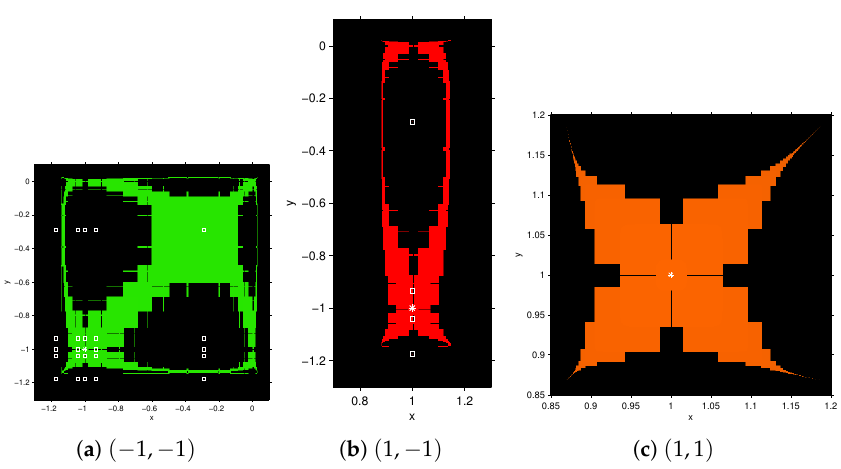
Figure 5. Basins of attraction of ( − 1, − 1 ) , ( 1, − 1 ) and ( 1,1 ) for FMN 3 method on r ( x ) . Green, orange, red and blue areas are the basins of attraction of the roots of q ( x ) (marked as white stars); black area denotes divergence and white squares are free critical